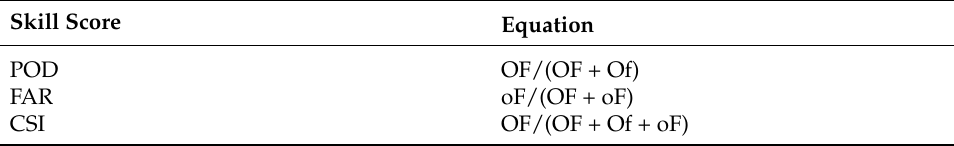
Table 1. Skill scores (Probability of Detection, POD; False Alarm Rate, FAR; and Critical Success Index, CSI) and the correspondent equation for each case (OF = Observation + Forecast, Of = Obser- vation + NOForecast, oF = NOObservation +